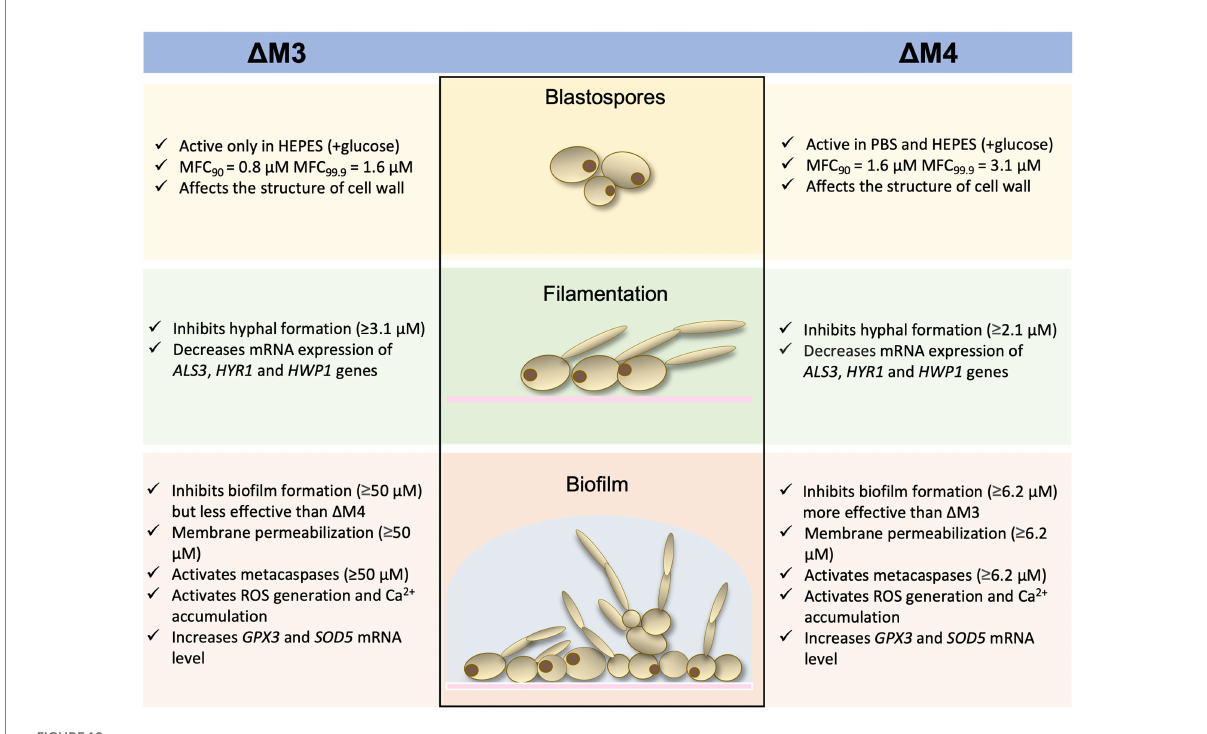
FIGURE 10 Diagram presenting a summary of the